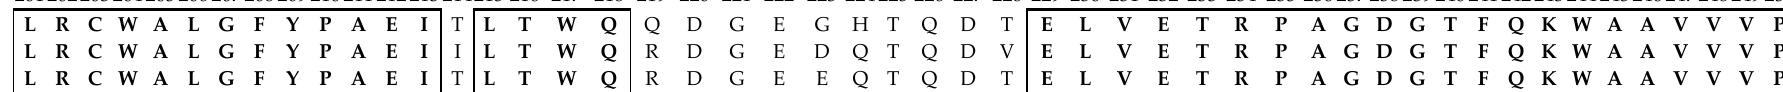
Table 2. Comparison of the amino acid sequence of HLA-E with sequences of five other HLA isoforms. Several peptide sequences of HLA-E are shared with the alleles of other HLA-I isoforms. Note that amino acid sequence AYDGKDY is shared with the maximum number of alleles of all isoforms of HLA-I, while sequences PRAPWMEQE and EPPKTHVT are shared with one allele of HLA-A (A*3306) and one allele of HLA-B (B*8201). The bioinformatics analysis was carried out using the Immune Epitope Database (IEDB) to predict the antigenicity rank of epitopes. The Chou and Fasman beta turn, Kolaskar and Tongaonkar antigenicity, Karplus and Schulz flexibility, and Parker hydrophilicity prediction methods